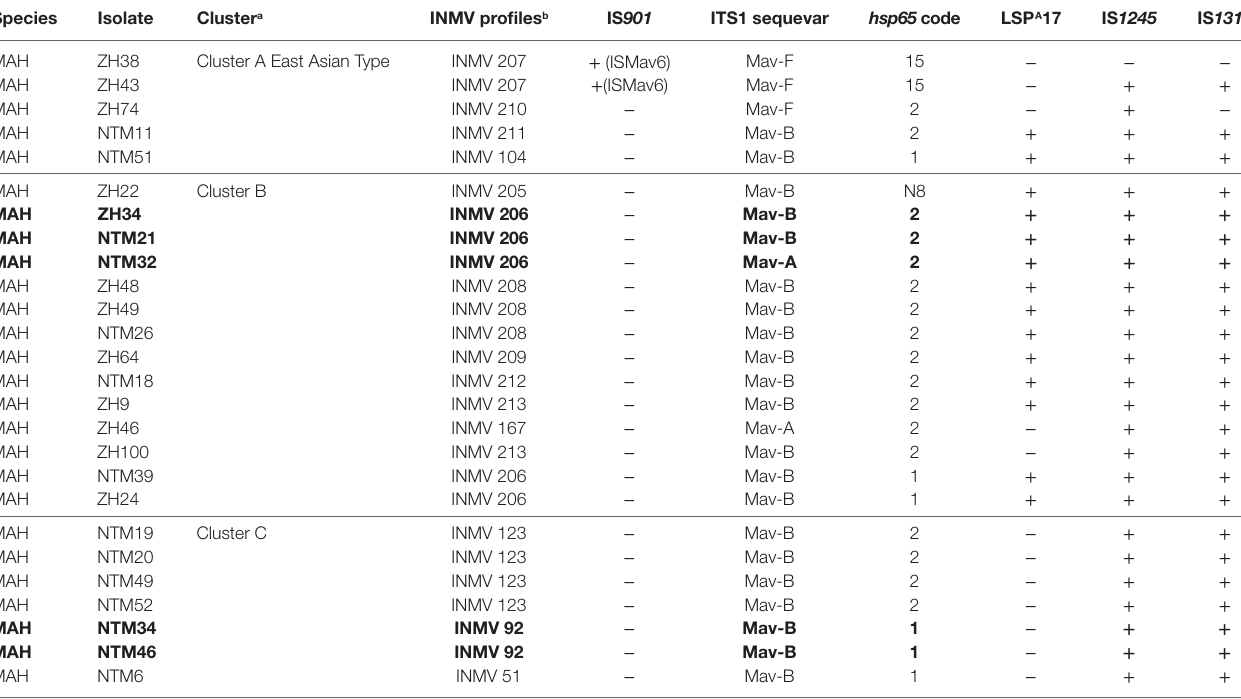
TaBle 2 | Molecular characteristics of 26 Swiss Mycobacterium avium subsp. hominissuis (MAH) isolates evaluated in this study. species isolate cluster a inMV profiles b is 901 iTs1 sequevar MAH ZH38 Cluster A East Asian Type